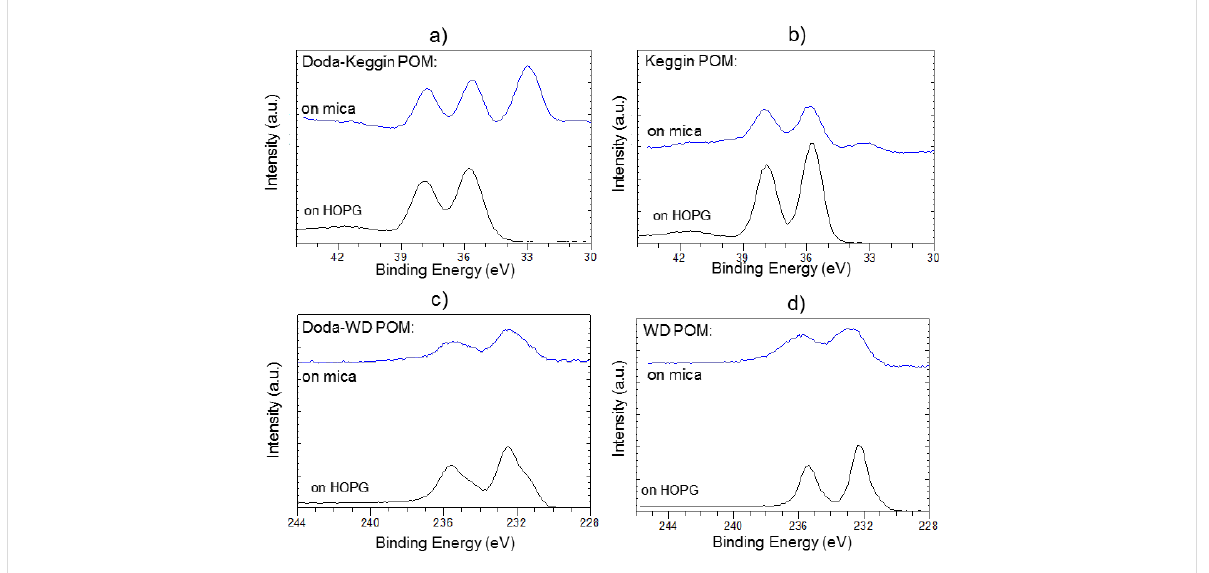
Figure 7: XPS analysis showing the core levels of different POMs and DODA–POM hybrids deposited on mica and HOPG surfaces. a) and b) are W 4f (37 and 35 eV) core levels of DODA–Keggin POM hybrid, and pure Keggin POM, respectively. c) and d) are Mo 3d (232 and 235 eV) core levels of DODA–WD POM hybrid and pure WD POM, respectively.